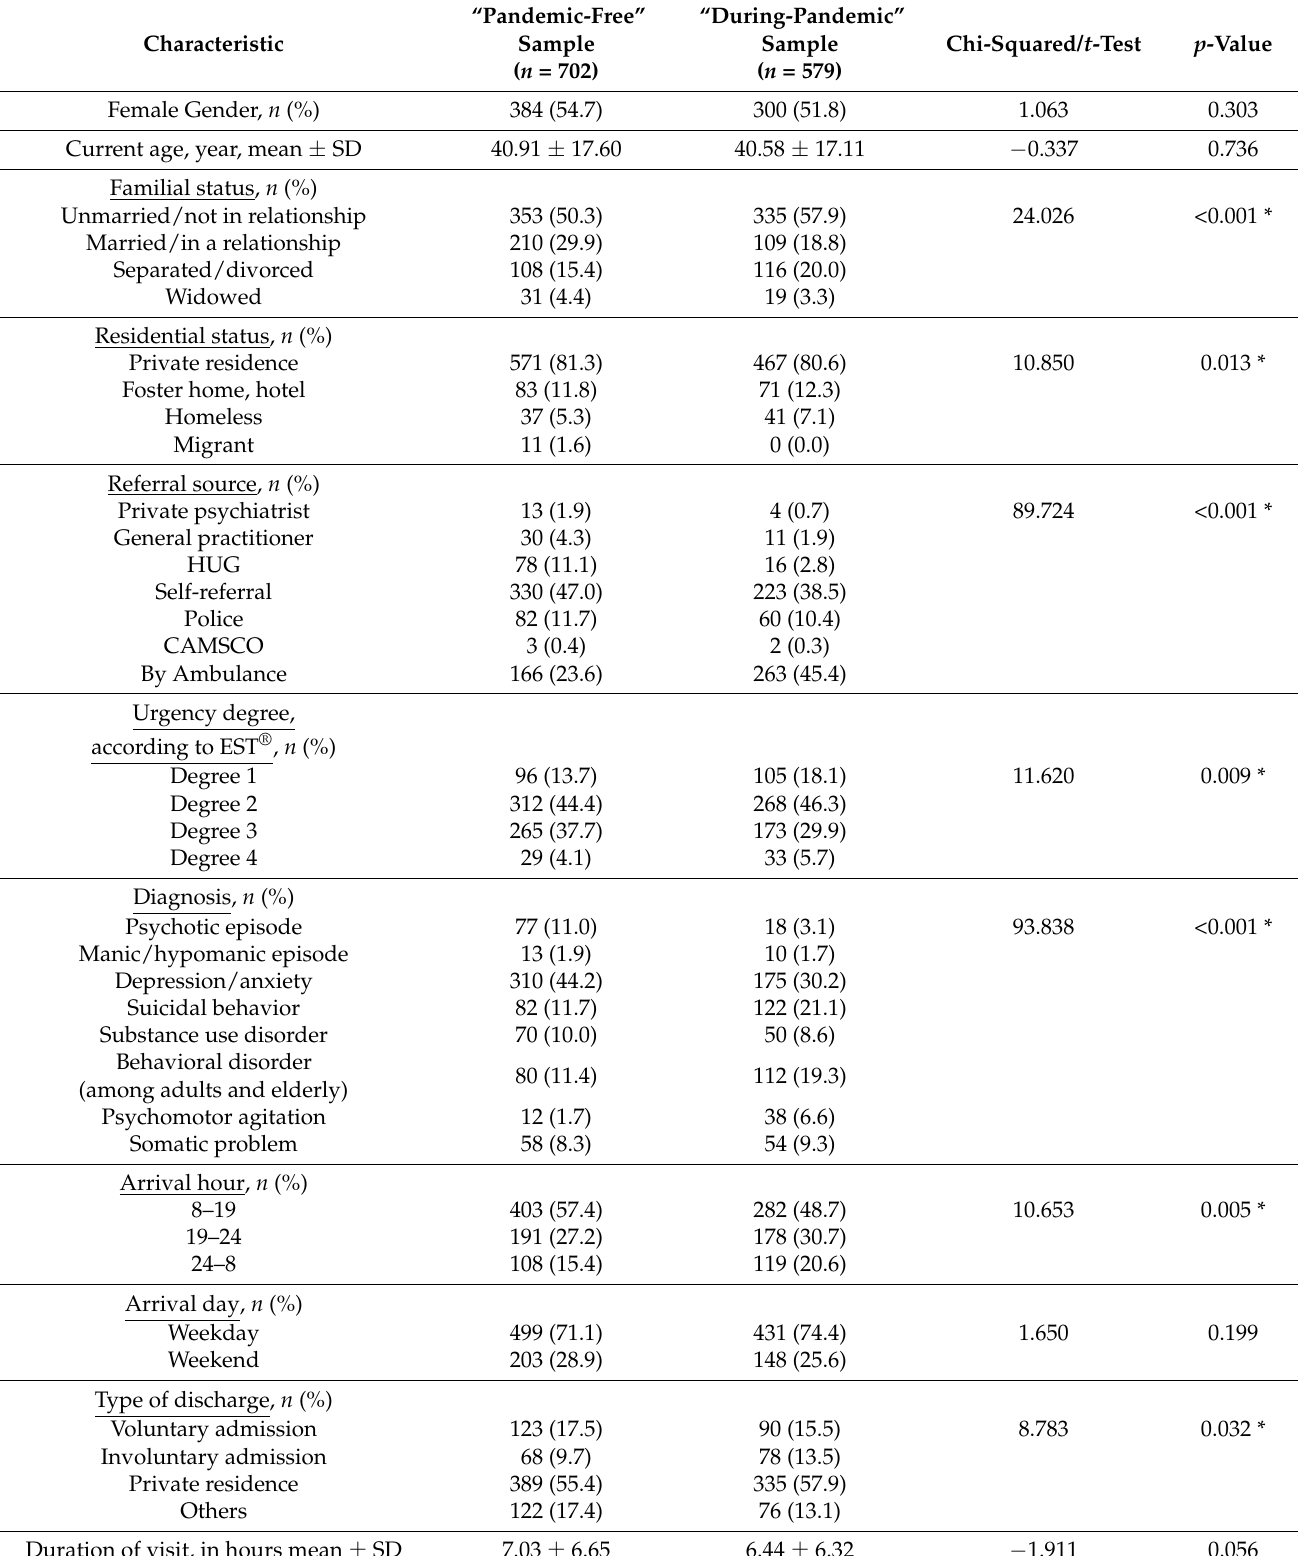
Table 1. Comparison of sociodemographic and clinical characteristics of patients admitted to the psychiatric emergency department (ED) during a “pandemic-free” period in 2016 and “during pandemic” period in